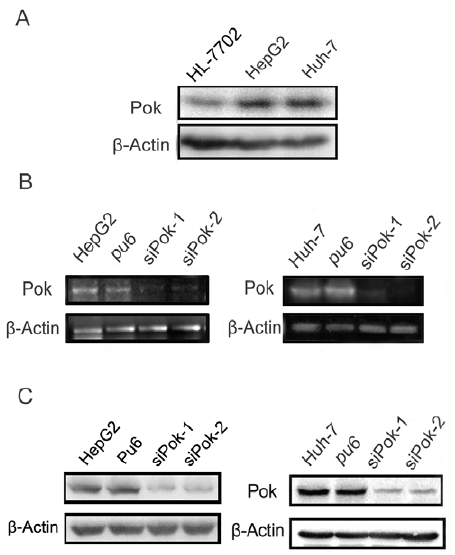
Figure 2. Pokemon protein expressions in human HepG2 and Huh-7 cell lines and the siRNA silencing effects of Pokemon. ( A ) Western blot analysis of Pokemon protein expression in the HepG2 and Huh-7 cell lines. The Pokemon expression in HL-7702 cells was used as a control, and the expression of b -actin was used as an internal control; ( B ) RT–PCR analysis of the Pokemon RNA level in HepG2 and Huh-7 cells that were stably transfected with Pokemon siRNA or the Pu6 vector control. The Pokemon expression levels in wild type HepG2 and Huh-7 cells were used as positive controls. ( C ) Western blot analysis to confirm the siRNA silencing of Pokemon, with b -actin used as a loading